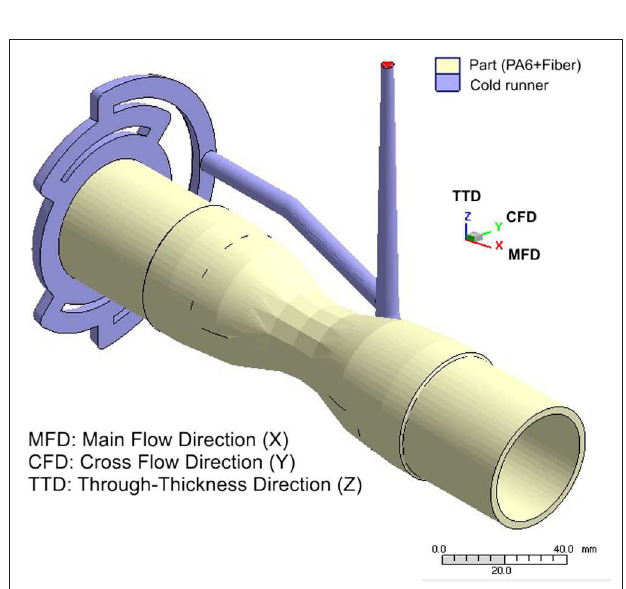
FIGURE 2 | Computational model.